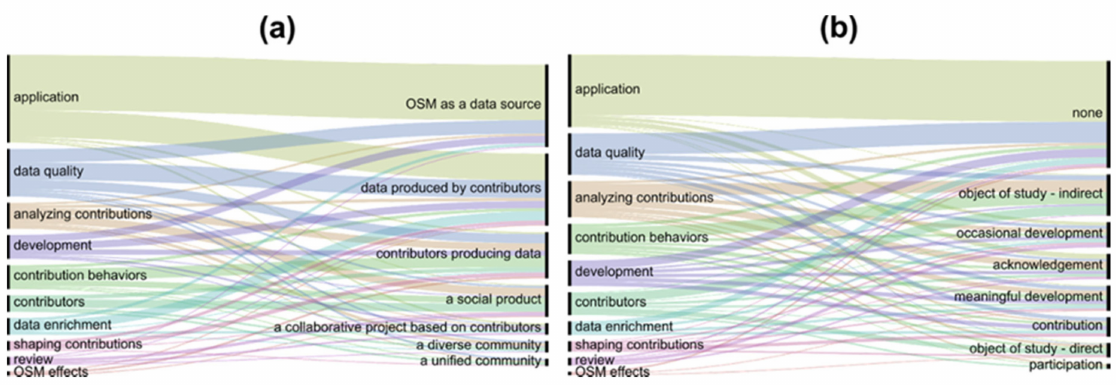
Figure 5. Alluvial diagrams connecting topic with perspective ( a ) and engagement ( b